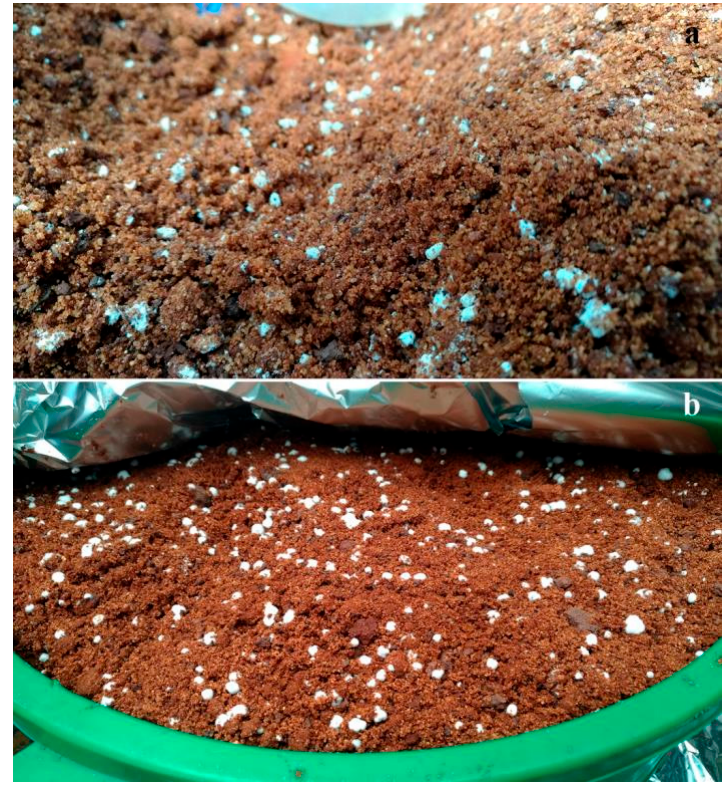
Figure 2. Fungi developed in the premix soil after 7 days of incubation: ( a ) Mb7-GFP; ( b ) GHA-GFP.